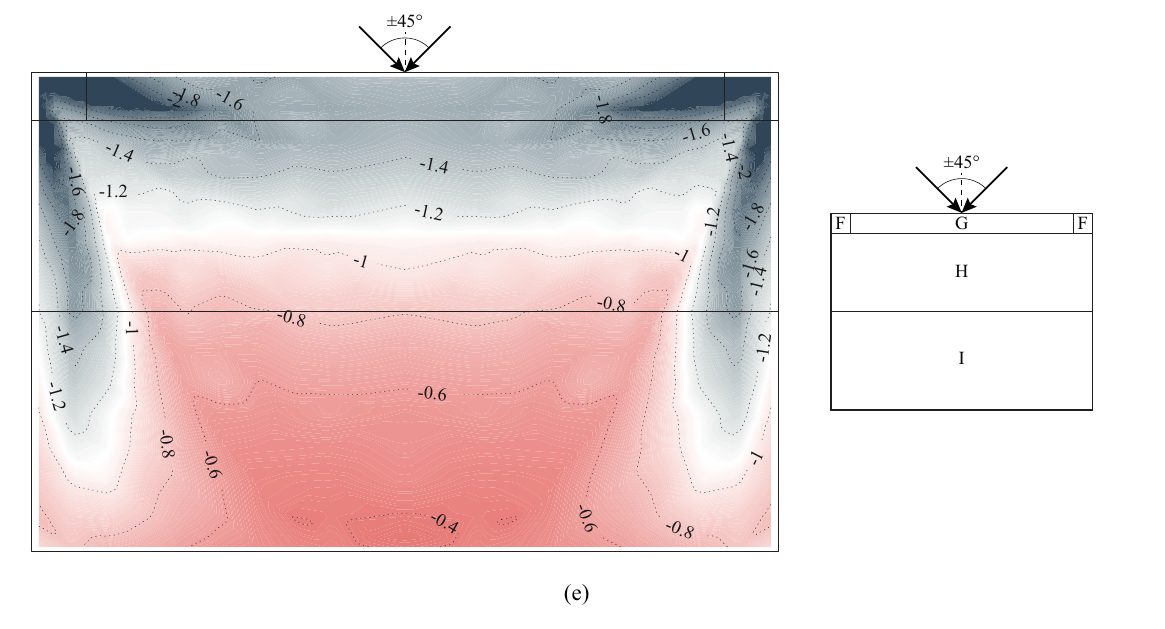
Figure 3. Pressure coefficients c p ,1 ( τ = 0.25s) for wind angles θ = 0 ◦ ( a ), θ = 15 ◦ ( b ), θ = 30 ◦ ( c ), and θ = 45 ◦ ( d ). Envelope of c p ,1 for θ = 0 ◦ , ± 15 ◦ , ± 30 ◦ , ± 45 ◦ , and Eurocode 1 loading zones ( e ).